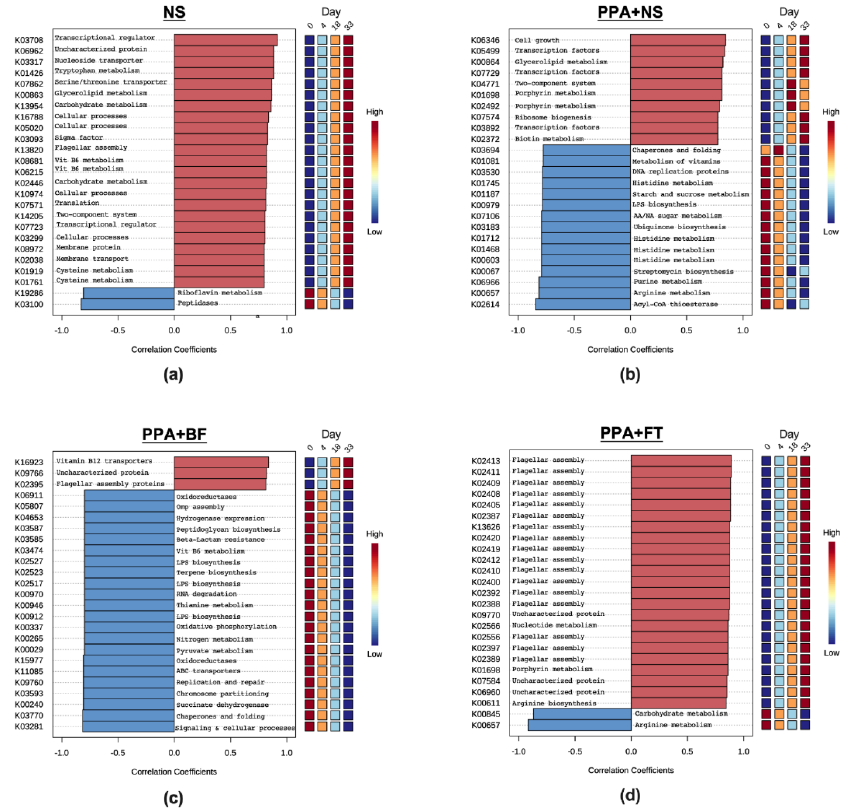
Figure 8 . Correlation between the predicted KEGG Orthology annotations and intervention dura- tion. Histograms show Spearman rank correlation coefficients (R) of the top 25 KEGG Orthology annotations with significant correlations ( p < 0.05). Normal saline control (NS) group ( a ), propionic acid control (PPA + NS) group ( b ), Bifidobacterium treated (PPA + BF) group, ( c ), fecal microbiota transplantation treated (PPA + FT) group ( d ).